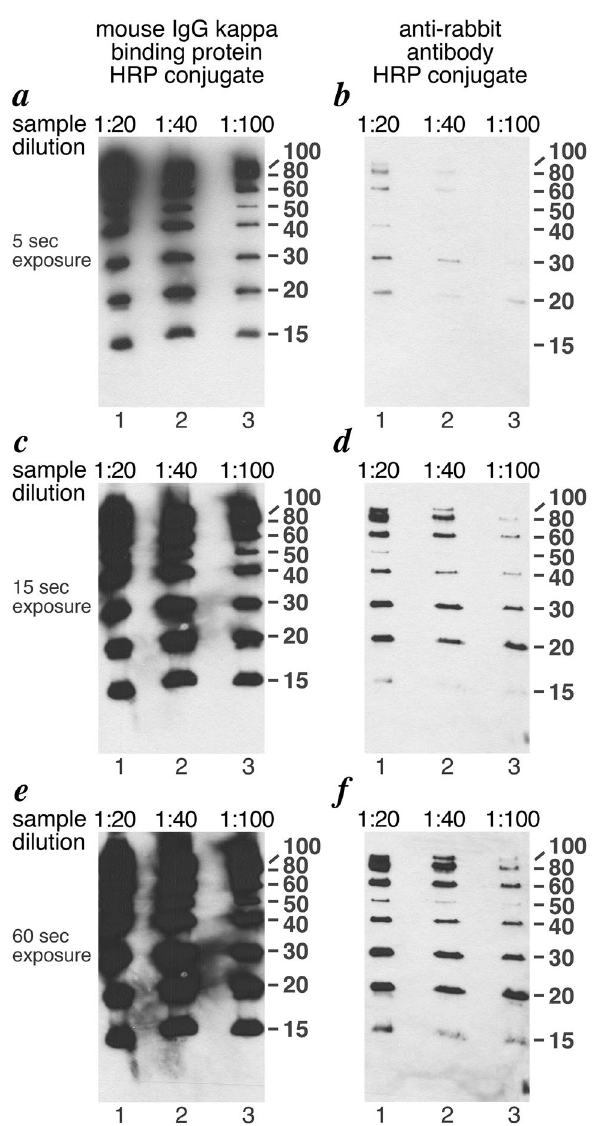
Figure 5. Use of Penn State protein ladder in Western blots. The Penn State ladder containing 10, 15, 20, 30, 40, 50, 60, 80 100 kD proteins are shown in each panel at ( a ) 1:20, 1:40 and 1:100 dilution in lanes 1, 2 and 3 respectively. Panels ( a ), ( c ) and ( e ) show the ladders detected via the Protein A IgG binding domain(s) using a 1:5000 dilution of the mouse IgG kappa binding protein HRP conjugate (Santa Cruz sc516102) while panels ( b ), ( d ) and ( f ) were detected using a 1:5000 dilution of the HRP-linked donkey anti-rabbit IgG (Cytiva NA934- 1ML). The blots were developed using SuperSignal West Pico PLUS chemiluminescent substrate (ThermoFisher 34580) and exposed to X-ray film for 5 sec (panels a and b ), 15 sec (panels c and d ) or 60 sec (panels e and f